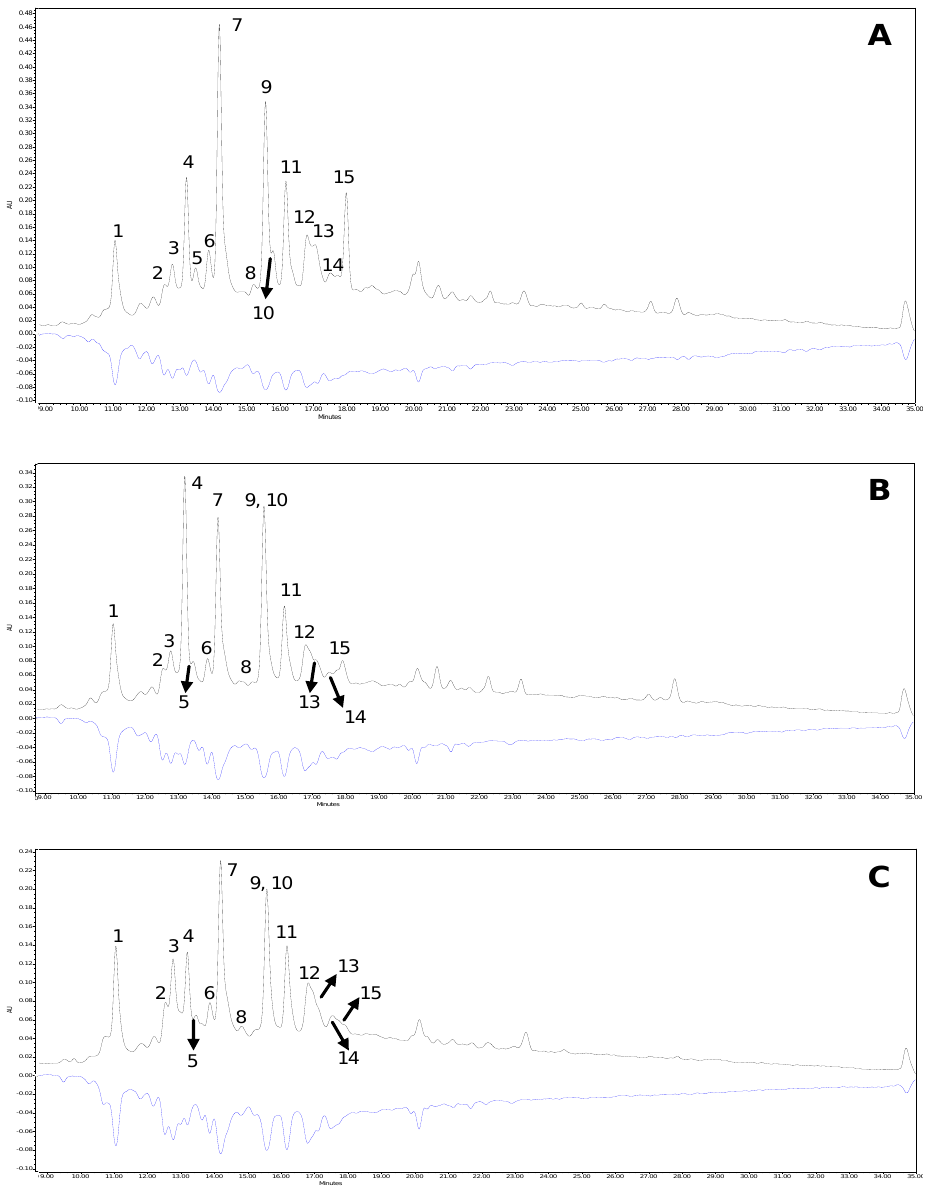
Figure 1. Segment (9.0 to 35.0 min) of chromatographic profiles obtained before and after the derivatization process using the ABTS reagent in samples of Chaenomeles × superba ‘Texas Scarlet’ ( A ), Chaenomeles × superba ‘Cameo’ ( B ), and Chaenomeles speciosa ‘Nivalis’ ( C ). Peak number identities are displayed in Table 2.